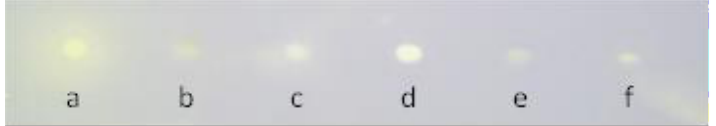
Figure 1. COX-2 TLC assay with 50 µg of some standard compounds: ( a ) eugenol, ( b ) salicylic acid, ( c ) celecoxib, ( d ) ibuprofen, ( e ) acetylsalicylic acid, ( f ) diclofenac.